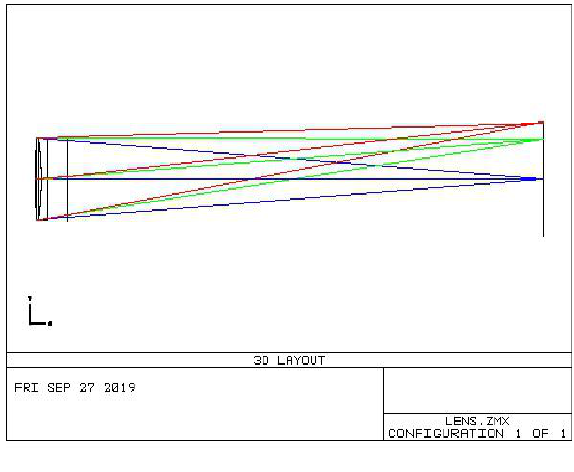
Figure 9. 3-D layout of lens